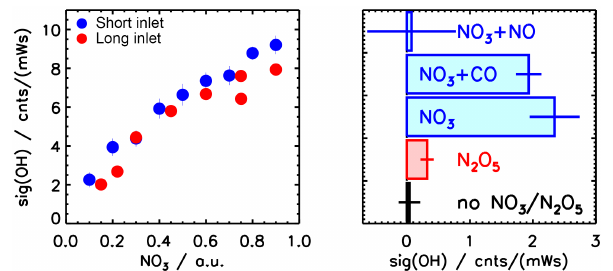
Figure 9. OH signals when air containing NO 3 produced from ther- mal decomposition of frozen N 2 O 5 is sampled for two designs of the OH fluorescence cell. Left panel: variation of NO 3 concentra- tion by changing the air flow through the N 2 O 5 source. Right panel: no OH signal (cell with the short inlet) is seen without flow from the N 2 O 5 source; only a small signal is observed when N 2 O 5 is not ac- tively heated downstream of the source (small efficiency of N 2 O 5 dissociation); the large signal is observed when N 2 O 5 is sampled through an heated inlet (high efficiency of N 2 O 5 dissociation). The signal remains when CO is added to scavenge OH, but disappears when NO is added to scavenge NO 3